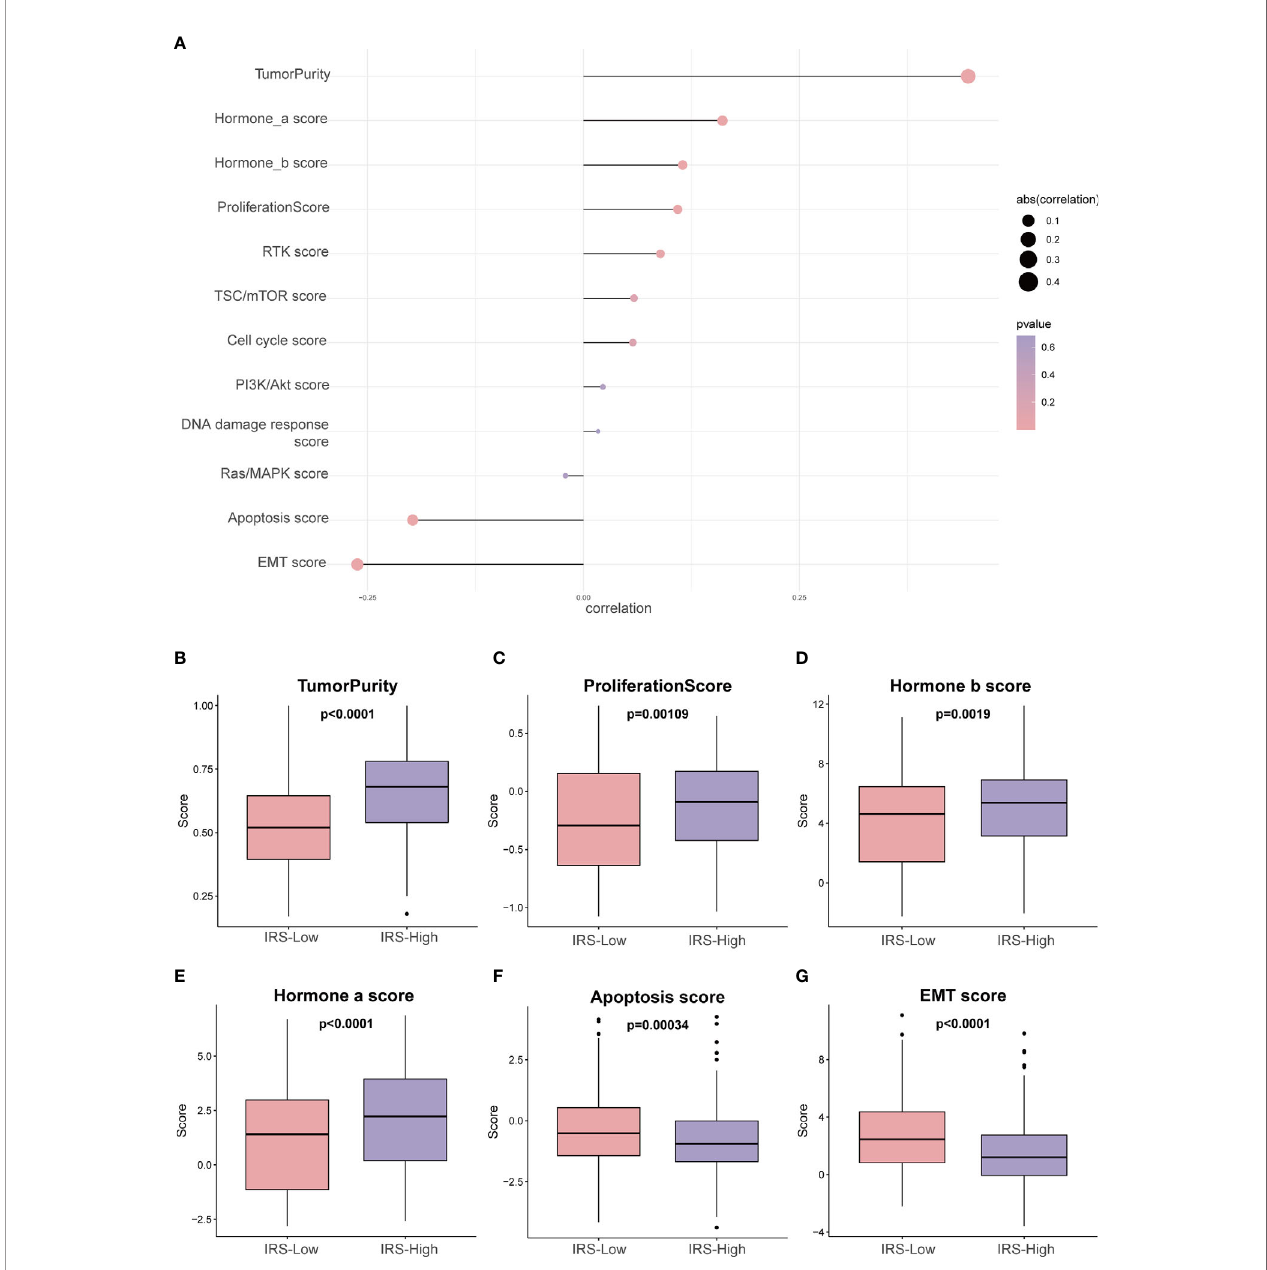
FIGURE 7 | Phenotype heterogeneity between the high- and low-IRS groups in the training set. (A) The bubble map shows the correlation between the IRS and RPPA data-based scores. Boxplots show differences in (B) tumor purity, (C) proliferation, (D) hormone_b, (E) hormone_a, (F) apoptosis, and (G) EMT. The Kruskal – Wallis test was performed to calculate the P-value. IRS, immune-related risk score; RPPA, reversed-phase protein array; EMT, epithelial – mesenchymal